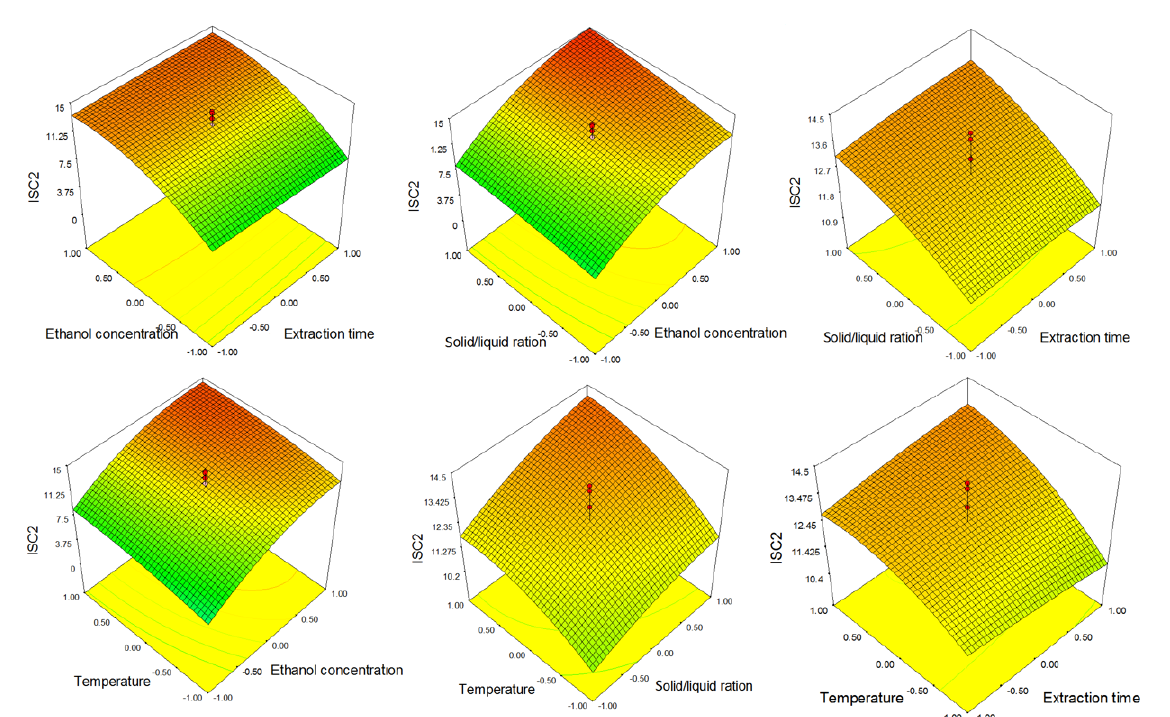
Figure 4. Response surfaces showing the combined effect of parameters on 4 (cid:48) - O -methylisoscutellarein-7- O -[6 (cid:48)(cid:48)(cid:48) - O -acetyl- β - D -allopyranosyl-(1 → 2)]- β - D -glucopyranoside (ISC